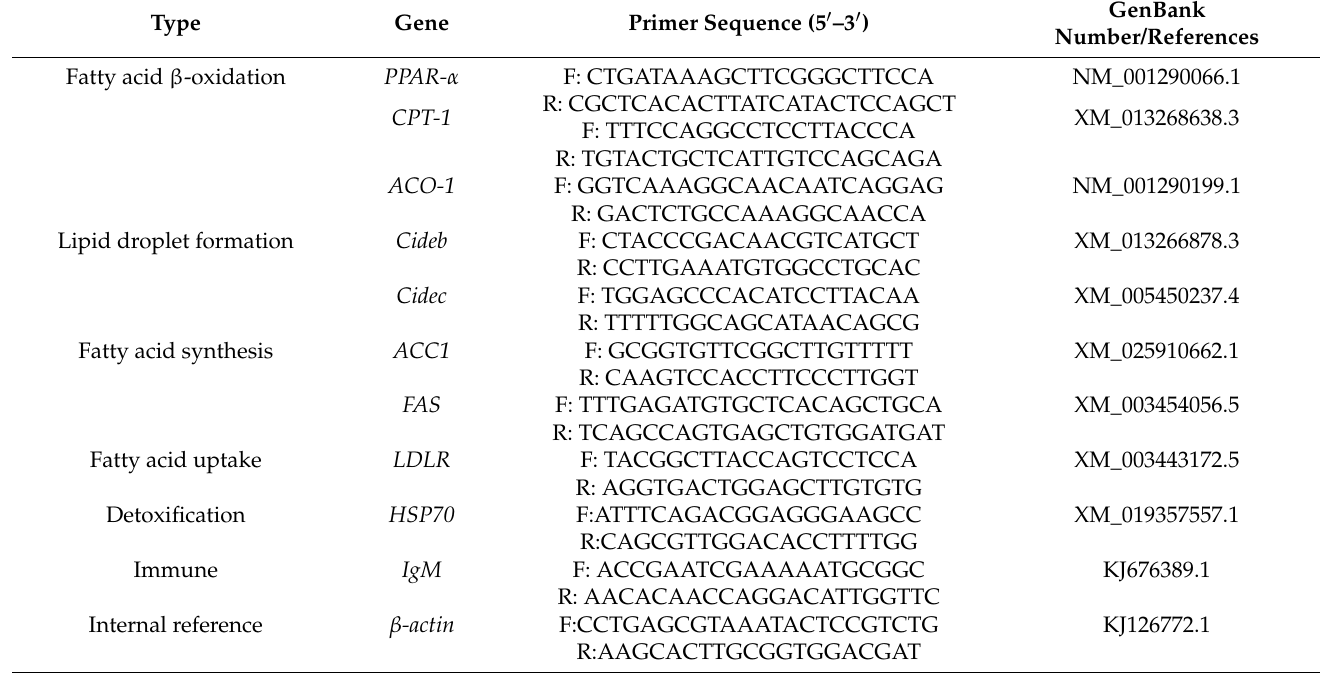
Table 1. The primer sequences used in the present study.